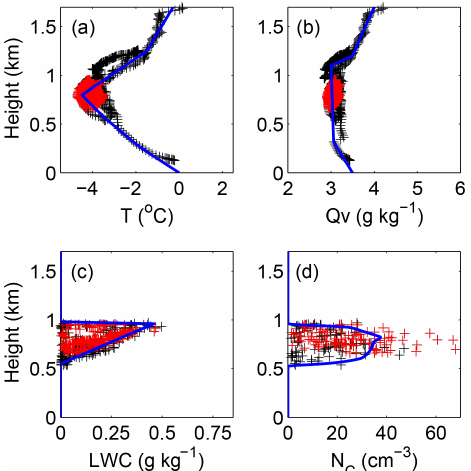
Figure 2. Measurements of (a) temperature ( ◦ C), (b) specific hu- midity (gkg − 1 ), (c) liquid water content (gkg − 1 ), and (d) cloud droplet concentration (cm − 3 ) collected on 23 July 2013 (10:00– 11:00UTC) are indicated with black crosses. Red crosses indicate the measurements collected over the ice pack (above 81.7 ◦ N); these are used to evaluate the simulated cloud properties. The blue lines in panels (a–c) represent the simplified vertical profiles used to ini- tialize the LES, while in panel (d) the blue line indicates the cloud droplet concentrations generated by the LES with CCN activation after 1h of